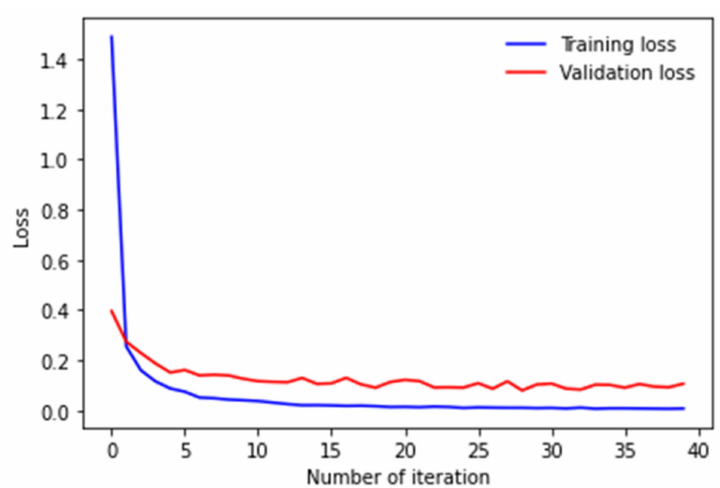
Figure 12. Training and validation learning curves on